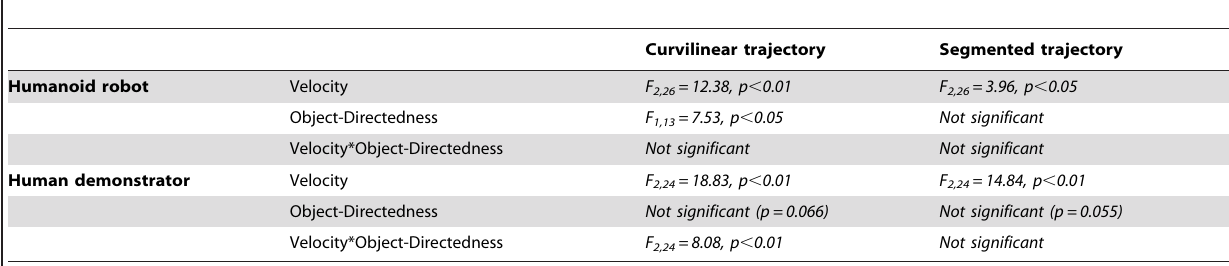
Table 3. Results of the statistical analyses on the participants’ mean velocity values (V P ) in the different experimental conditions.